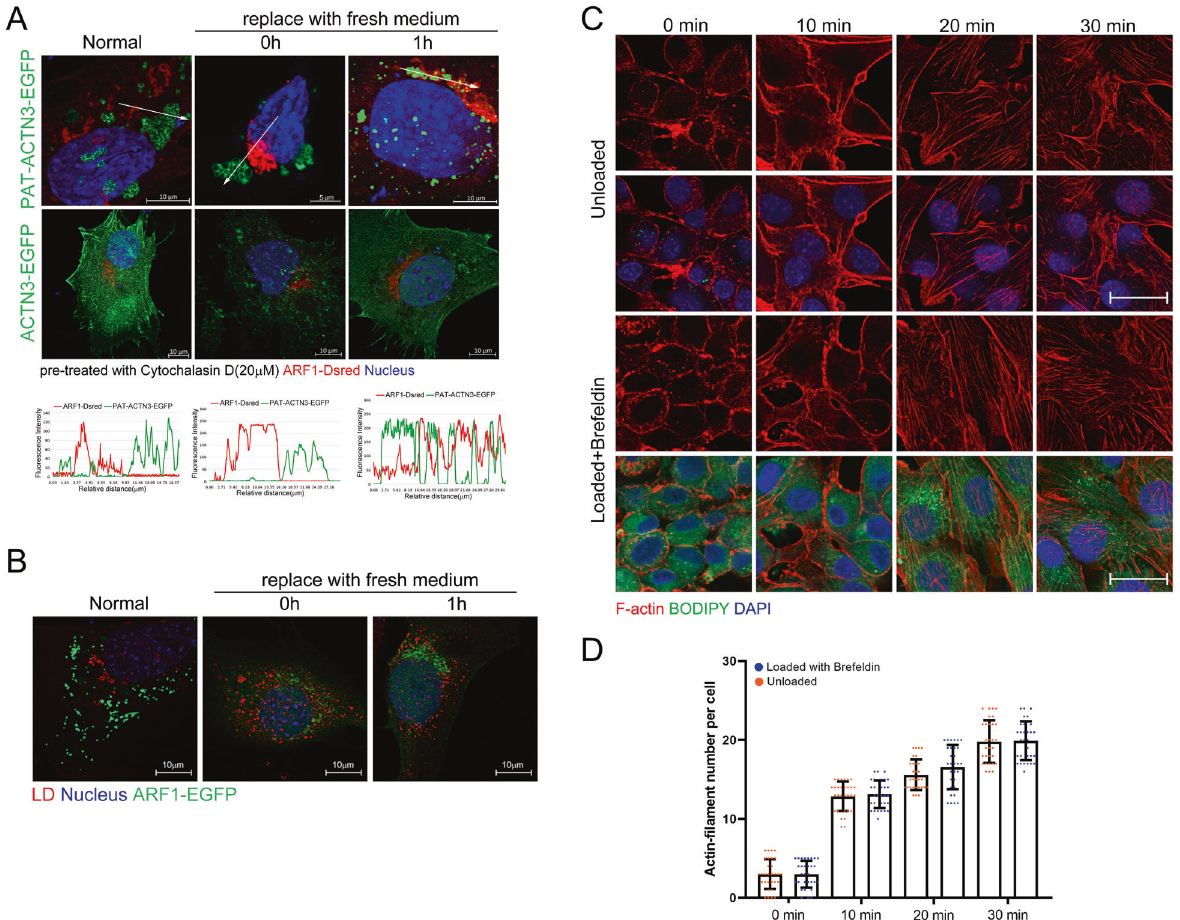
Fig. 6 ARF1-dependent vesicles mediate the transfer of actinin from LDs to micro fi laments. A The C2C12 cells were treated with cytochalasin D for 2 h, then the medium was replaced with a fresh medium. The co-localization of PAT-ACTN3-EGFP and ARF1-DsRed was detected. The fl uorescence intensity, along with the arrow line, is plotted in the graph below. B The co-localization of LDs and ARF1-EGFP in C2C12 cells was detected. C The rate of actin- fi lament remodeling in loaded cells with brefeldin A treatment and unloaded cells, bar, 20 μ m. D The count of micro fi lament number per cell. * p < 0.05. Results are from three technical repeats ( N = 3) for a representative of three biological repeats ( N =